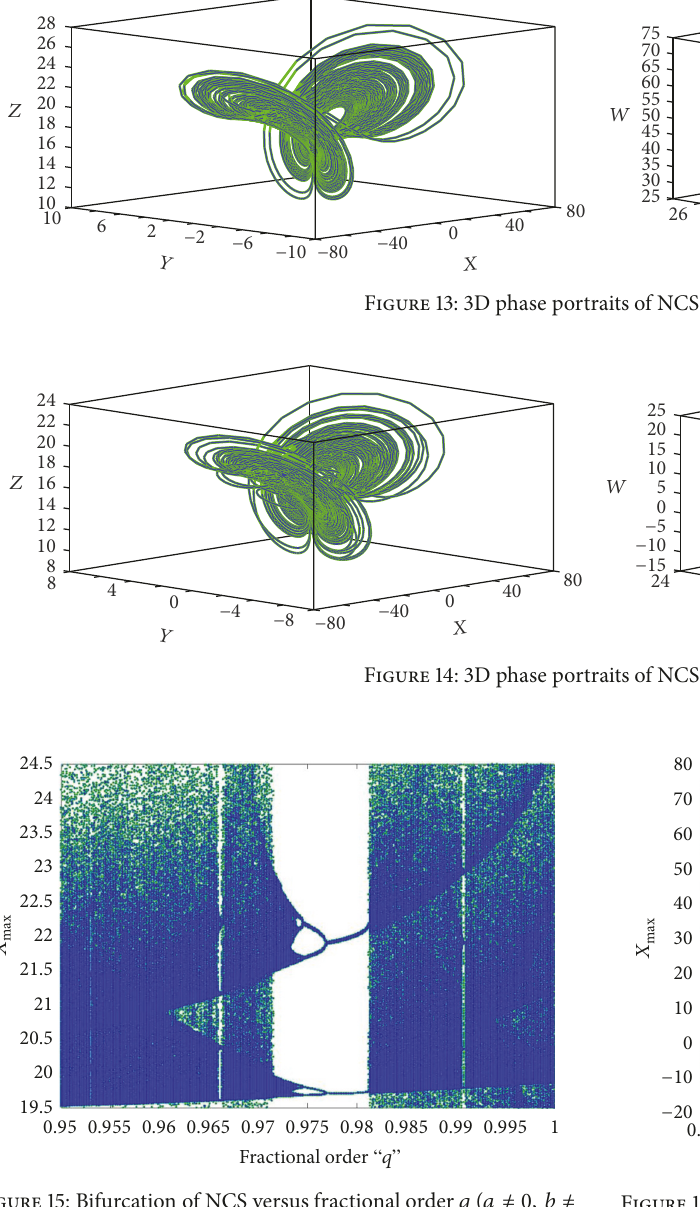
Figure 16: Bifurcation of NCS versus fractional order 𝑞 ( 𝑎 = 0, 𝑏 = 0